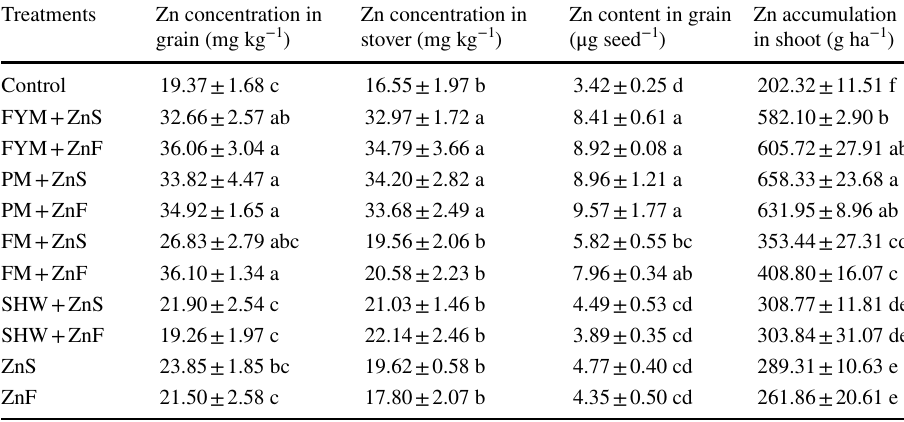
Different letters in the same column indicate significant differences by LSD at P ≤ 0.05 and ± indicate standard error ( n